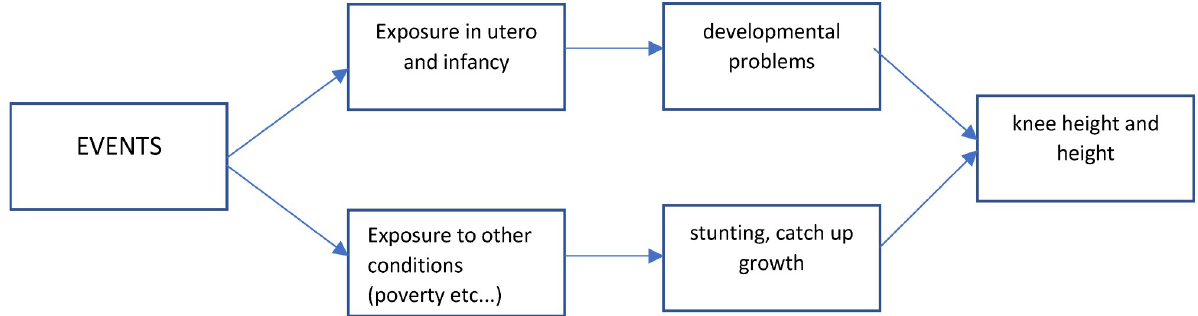
Fig 5. Graphic representation of relations under